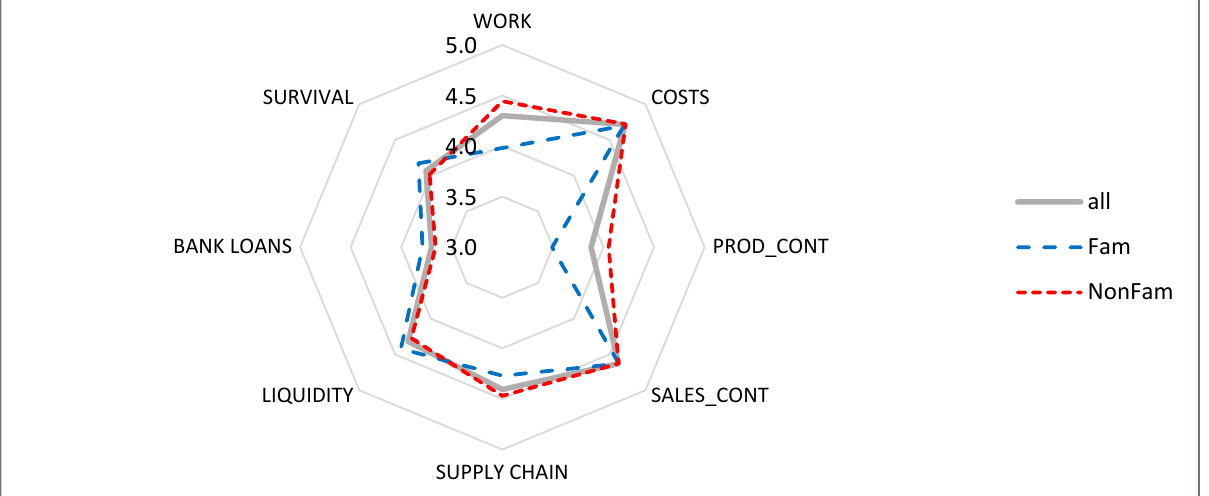
Figure 6. Perception of the COVID-19 interruptions in family and non-family businesses.